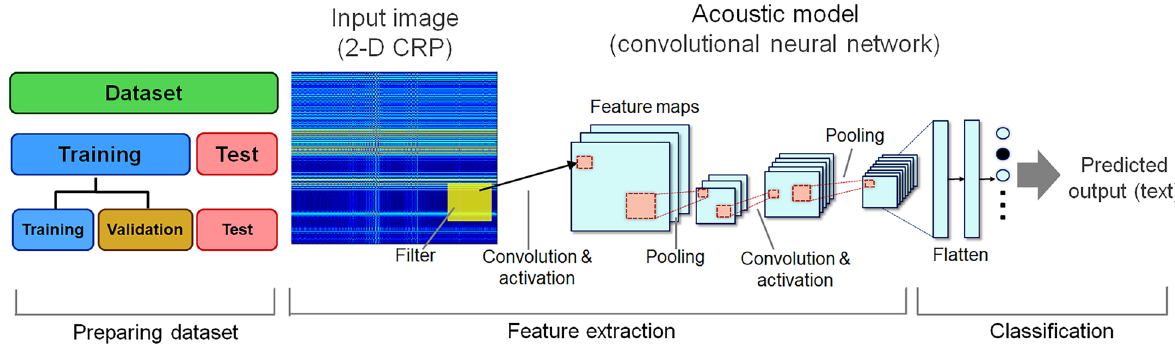
Figure 10. Architecture of the convolutional neural network model for speech